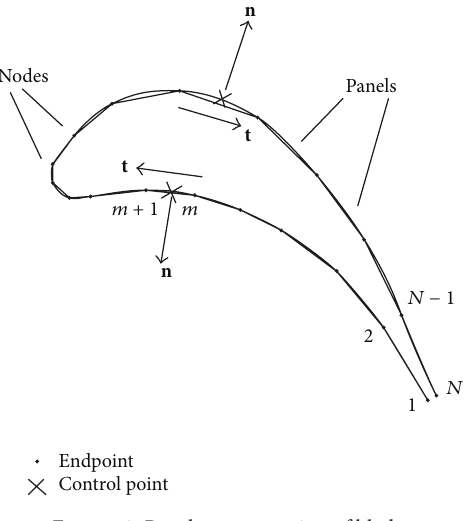
Figure 1: Flow through infinite cascade.